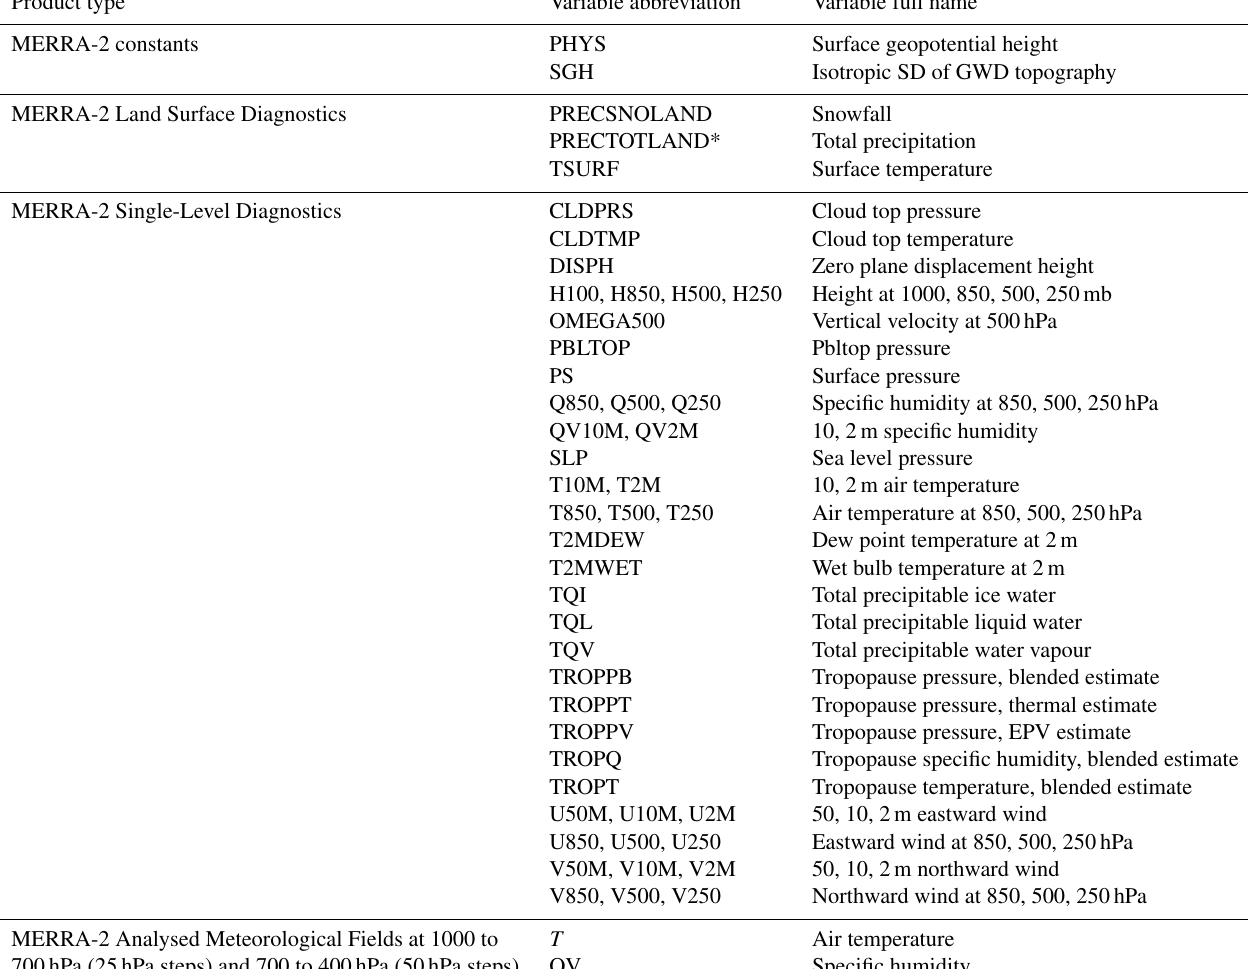
Table B2. MERRA-2 variables used in the